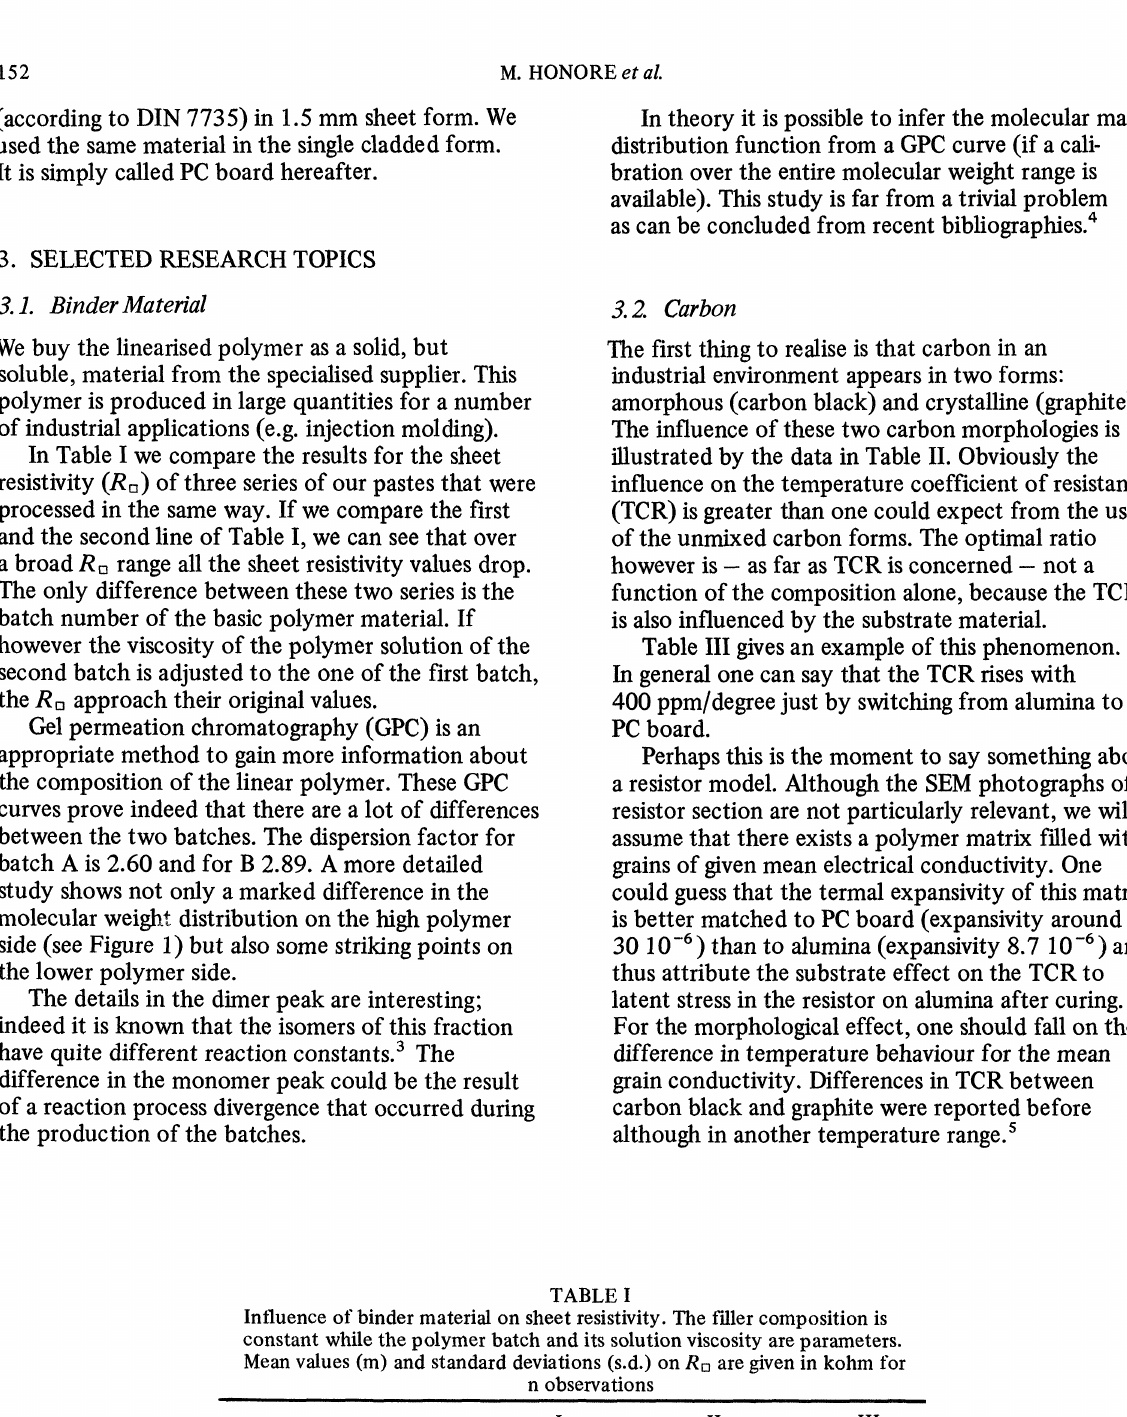
TABLE Influence of binder material on sheet resistivity. The f’fller composition is constant while the polymer batch and its solution viscosity are parameters. Mean values (m) and standard deviations (s.d.) on R are given in kohm for n observations